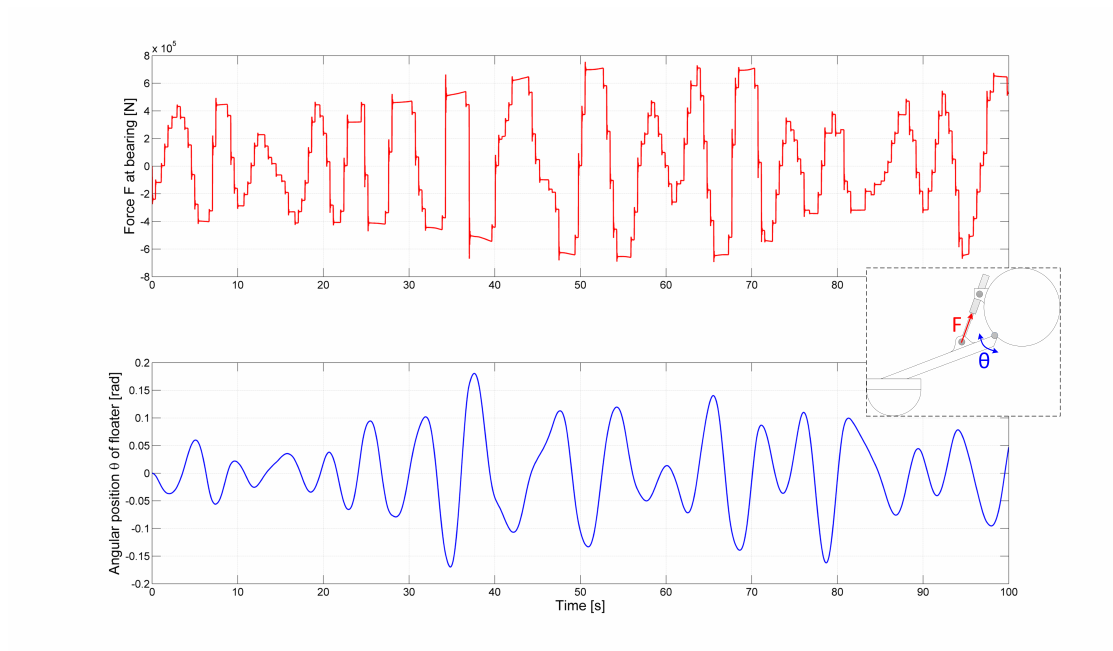
Figure 3. Detail of a time series example (here, H m 0 = 3.25 m; T 0,2 = 5.5 s) of the simulations showing the bearing load F , as well as the angular position θ of the floater. H m 0 : significant wave height; T 0,2 : mean wave